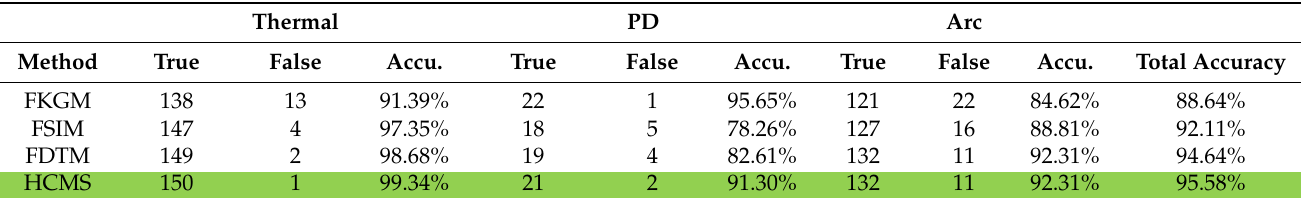
Table 6. Performance of the system with a mathematical approach *.